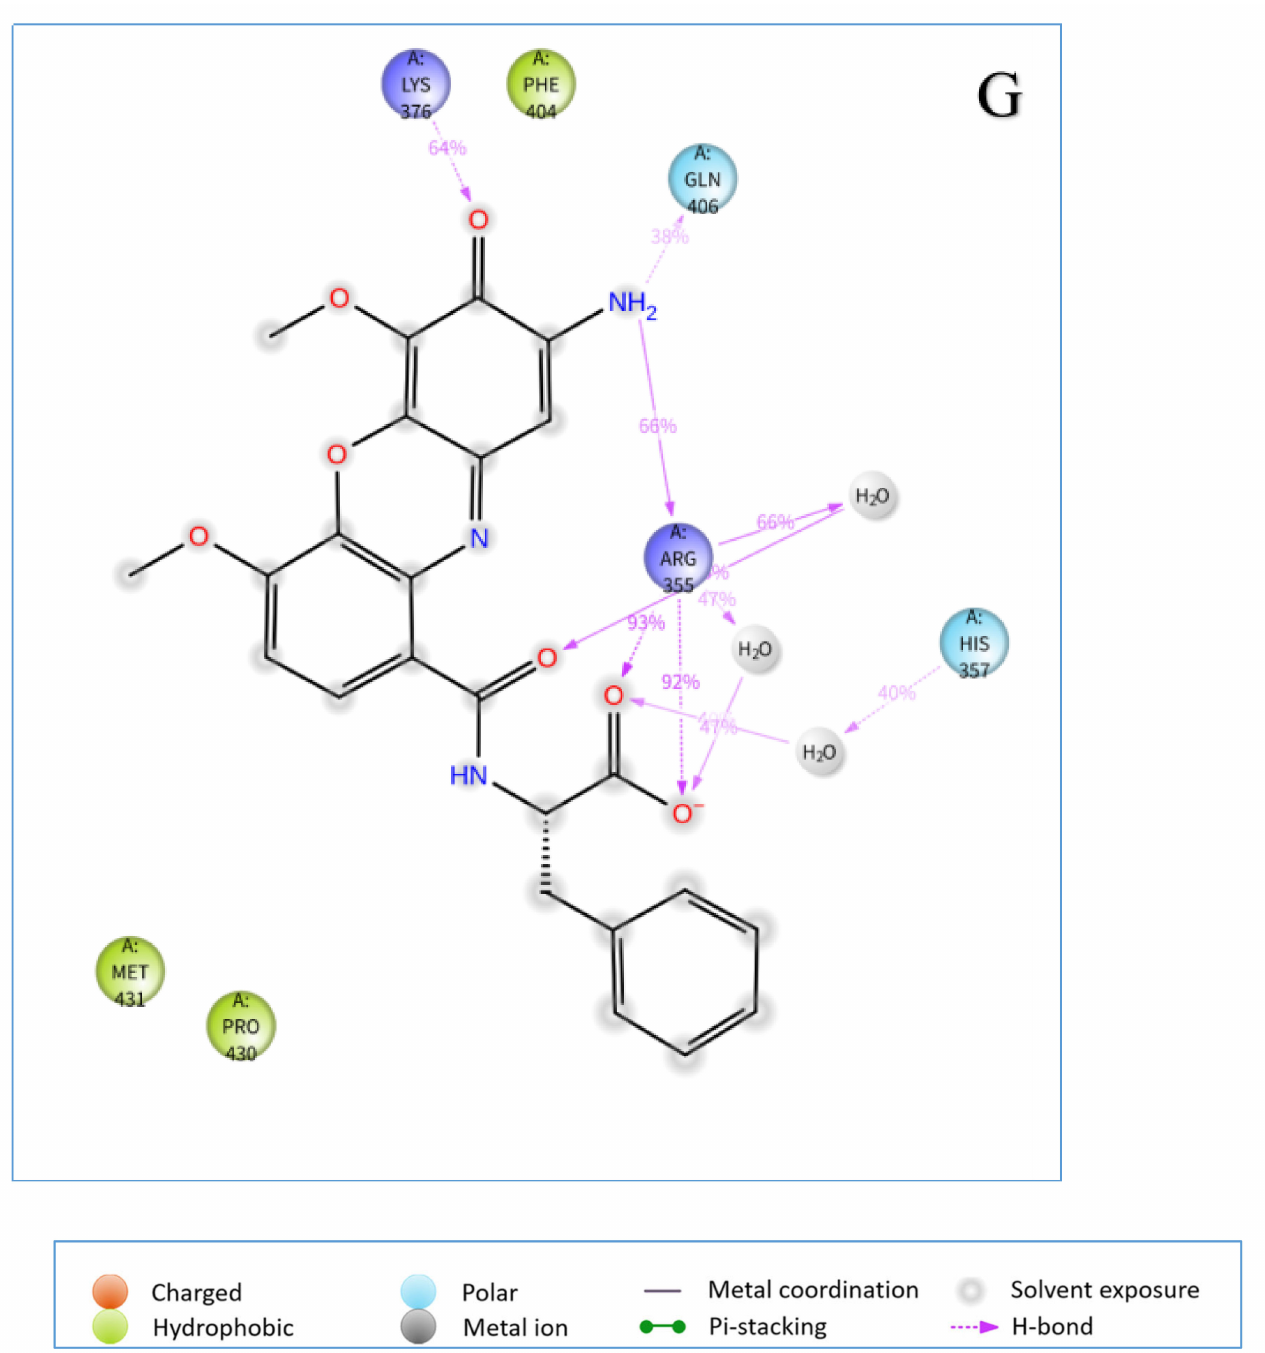
Figure 4. 2D summary of interaction analysis results of PB2-ligand complexes. The interaction pairs that occurred during more than 30% of the simulation time are included. Shown are interactions between ( A ) VX-787 and PB2; ( B ) Str1614 and PB2; ( C ) Str1916 and PB2; ( D ) Str3107 and PB2; ( E ): Str5776 and PB2; ( F ) Str6318 and PB2; and ( G ) Str7374 and